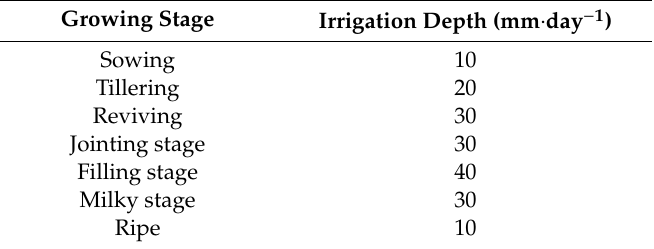
Table 2. Water depth meeting irrigation demand in rice-wheat rotation fields during the crop growing season